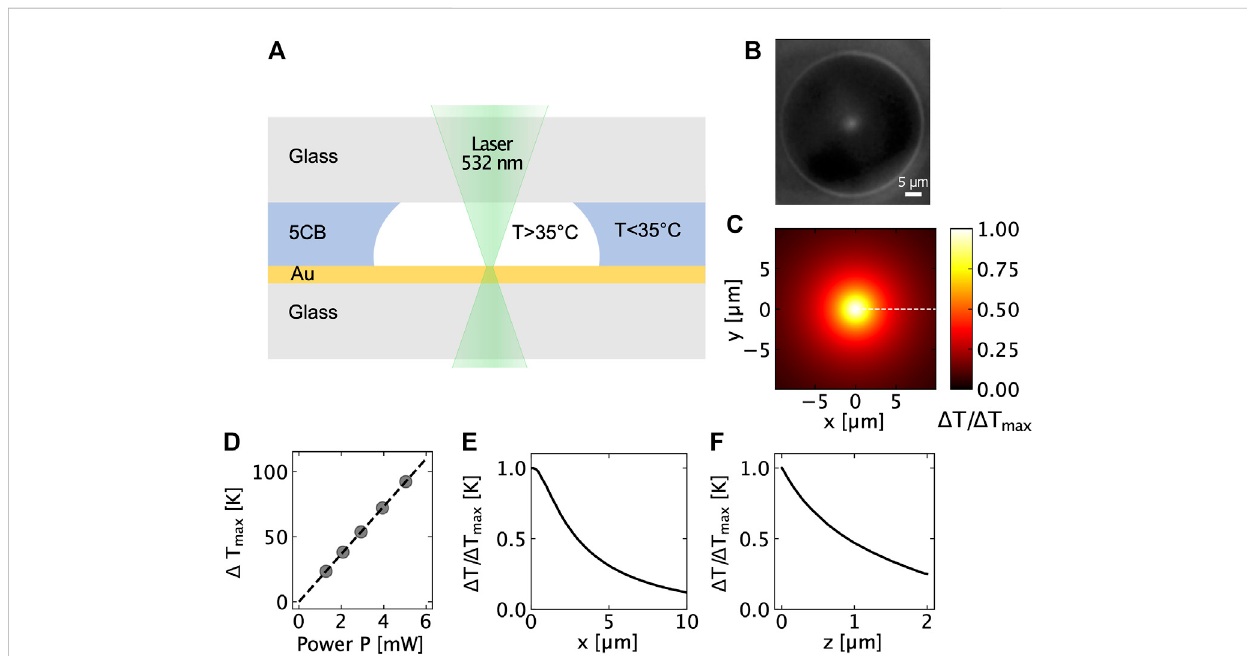
FIGURE 1 (A) Schematic of the temperature measurement using the 5CB technique, (B) Dark- fi eld image of the phase transition between the nematic and isotropicphaseofa5CBliquidcrystalwhenitisheatedbyafocusedlaser( p =2.98 mW), (C) Relativetemperatureincrement(Topview), (D) Temperature increment as a function of the laser power obtained using 5CB experiments, (E) Relative temperature increment pro fi le in xy -plane, and (F) Relative temperature increment pro fi le in xz